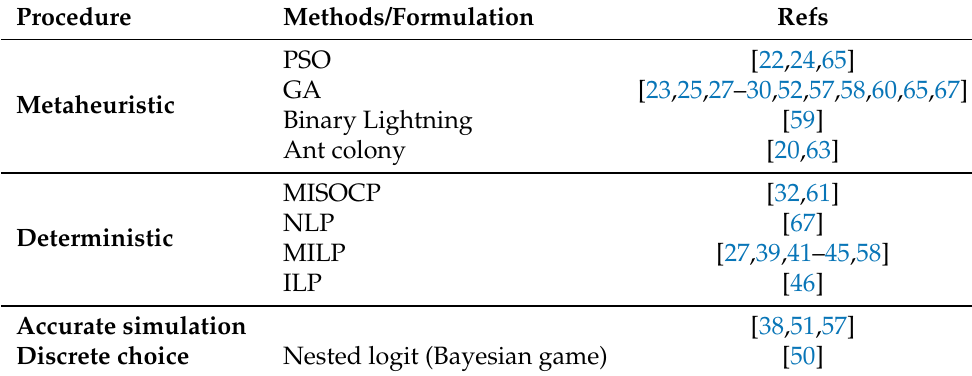
Table 7. Optimization resolution